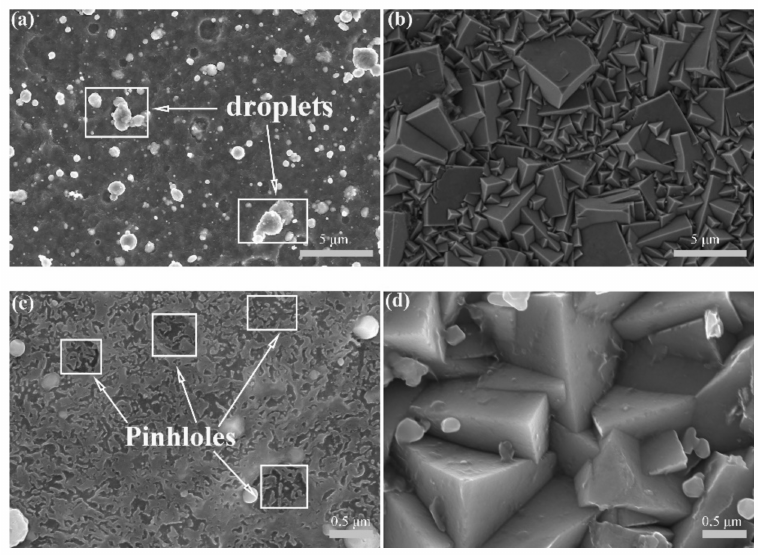
Figure 6. Surface morphologies of the Ti 1 − x Al x N coatings after a 20-day immersion corrosion test. ( a , b ) Original surface morphology and ( c , d ) corroded surface after immersion of PVD-Ti 0.40 Al 0.60 N and LPCVD-Ti 0.17 Al 0.83 N coatings,